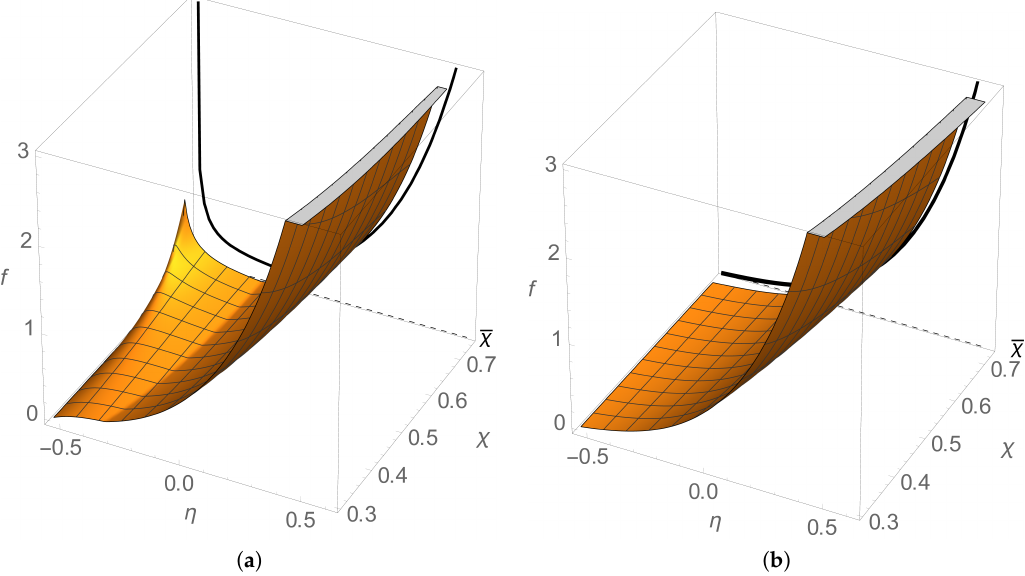
Figure 3. Comparison of ergodic densities f given the option to rent ( a ) and no option to rent ( b ) as the financing constraint χ is varied. Other parameters were set to baseline values. The lower boundary is recapitalising unto χ = ¯ χ ( ¯ χ (cid:39) 0.74 in ( a ) and 0.73 in ( b )), indicated by the thick solid line on the graph and dashed line on the axis. In ( a ) a left-boundary peak emerges for χ just less than ¯ χ . Density is infinite at ¯ η for χ > ¯ χ . Note the complete absence of the left-hand side peak in ( b